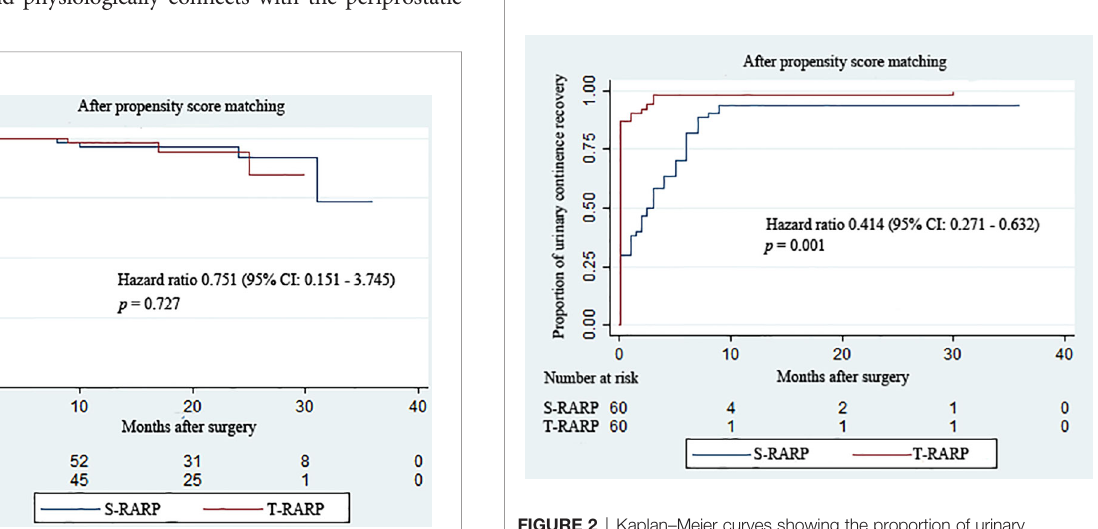
FIGURE 2 | Kaplan – Meier curves showing the proportion of urinary continence (UC) in patients undergoing the transvesical and standard approaches to robot-assisted radical prostatectomy during the follow-up intervals. UC was de fi ned as requiring no pad or preventively using one dry pad per